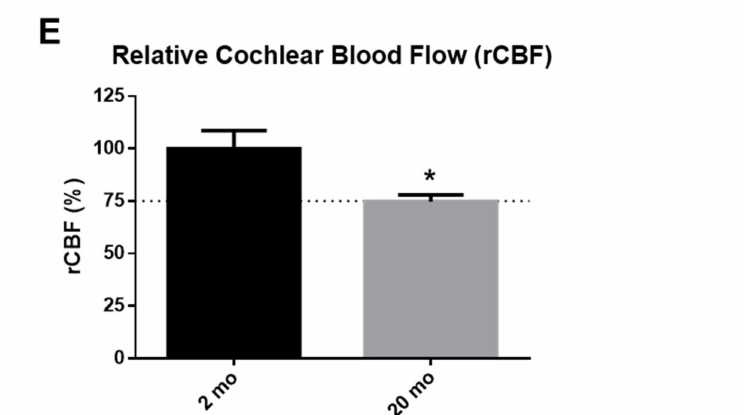
Figure 5. Microscopic images of lateral wall and cochlear blood flow of young and aging animals. ( A ) Young stria vascularis images taken by transmission electron microscopy (TEM) shows the three layers of strial cells, marginal (Mc), intermediate (Ic), and basal (Bc) cells, and the blood vessels (Vx) appear normal. ( B ) The stria vascularis degeneration in aging cochlea, as indicated by numerous vacuoles (red arrows), pigmentation (red arrows) and enlarged intercellular spaces, is obvious. Scale bar of A–B represents 5 µ m. ( C ) Normal mitochondria with distinct cristae in young stria vascularis. ( D ) Damaged mitochondria with degenerated cristae in aging stria vascularis. Scale bar of C,D represents 1 µ m. ( E ) Cochlear blood flow was measured using a 0.1 mm diameter laser Doppler probe placed over the lateral wall of the cochlea of the 2 and 20 months old C57BL / 6J male mice. Significantly decreased blood flow were observed in aging cochlea. Graphs represent mean ± S.E.M. * p < 0.05. Unpaired t -test. n = 5–8. Graphs represent mean ± S.E.M. * p < 0.05. t -test. n =